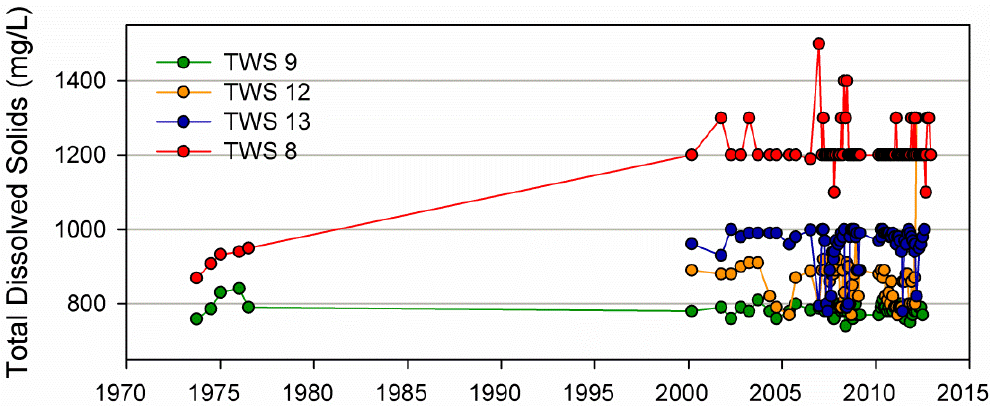
Figure 11. Salinity in Kingston SE water supply